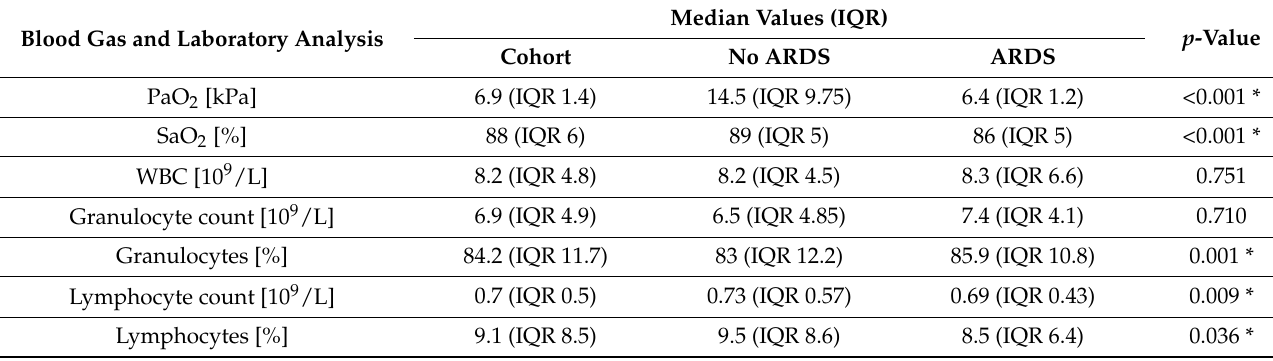
Table 3. Admission blood gas and laboratory analysis, with regard to ARDS